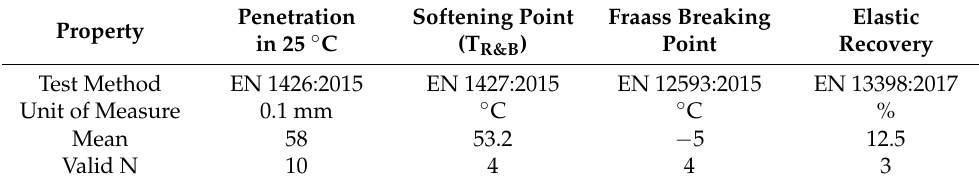
Table 5. Test results of asphalt extracted from reclaimed asphalt pavement (RAP). Property